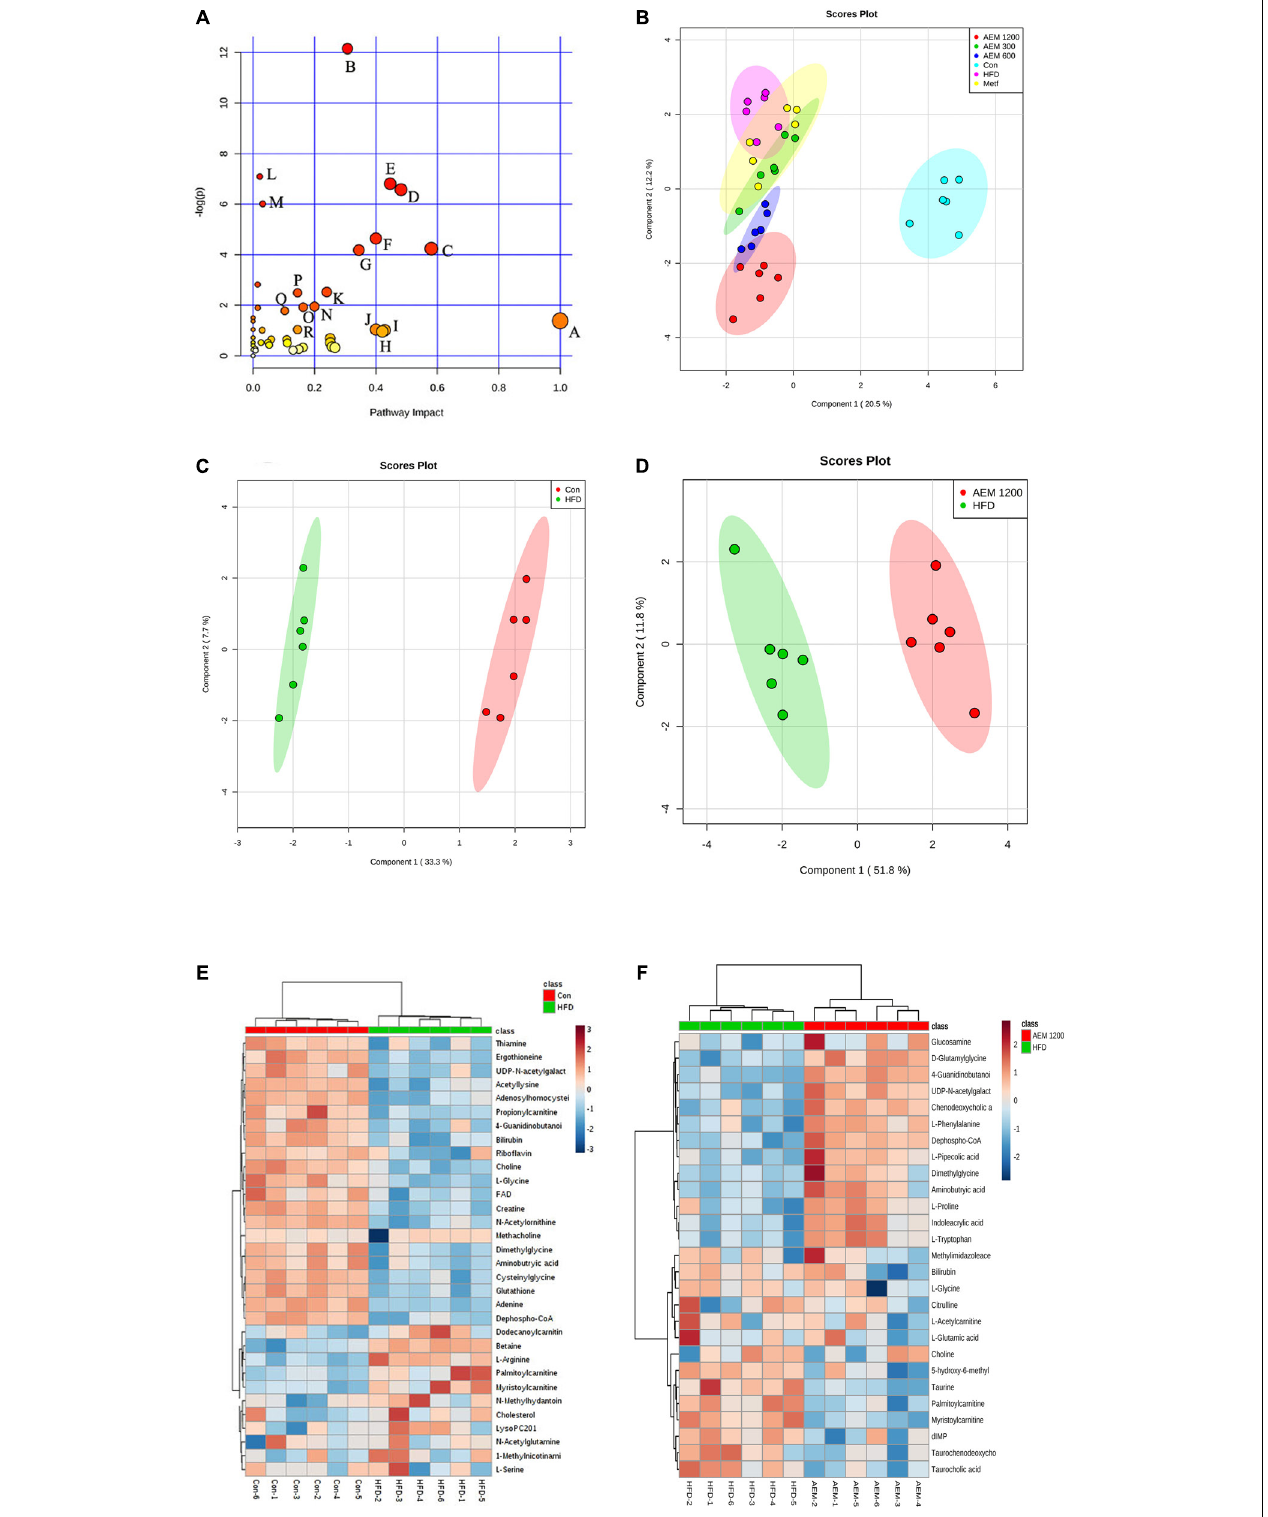
FIGURE 3 | Aqueous extract of black maca (AEM) regulated the disturbed metabolism. (A) Summary of pathway analysis with MetPA. A, D -Glutamine and D -glutamate metabolism; B, Arginine and proline metabolism; C, Glyoxylate and dicarboxylate metabolism; D, Glutathione metabolism; E, Nicotinate and